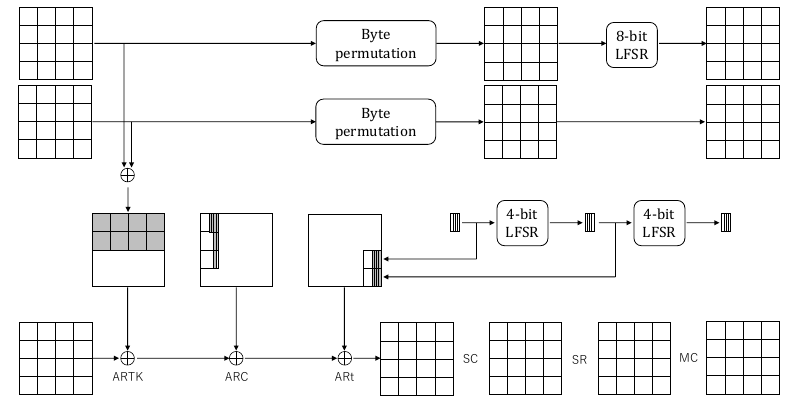
Figure 13: Round Function of TweSKINNY-128-256. Grey bits are the added bits.